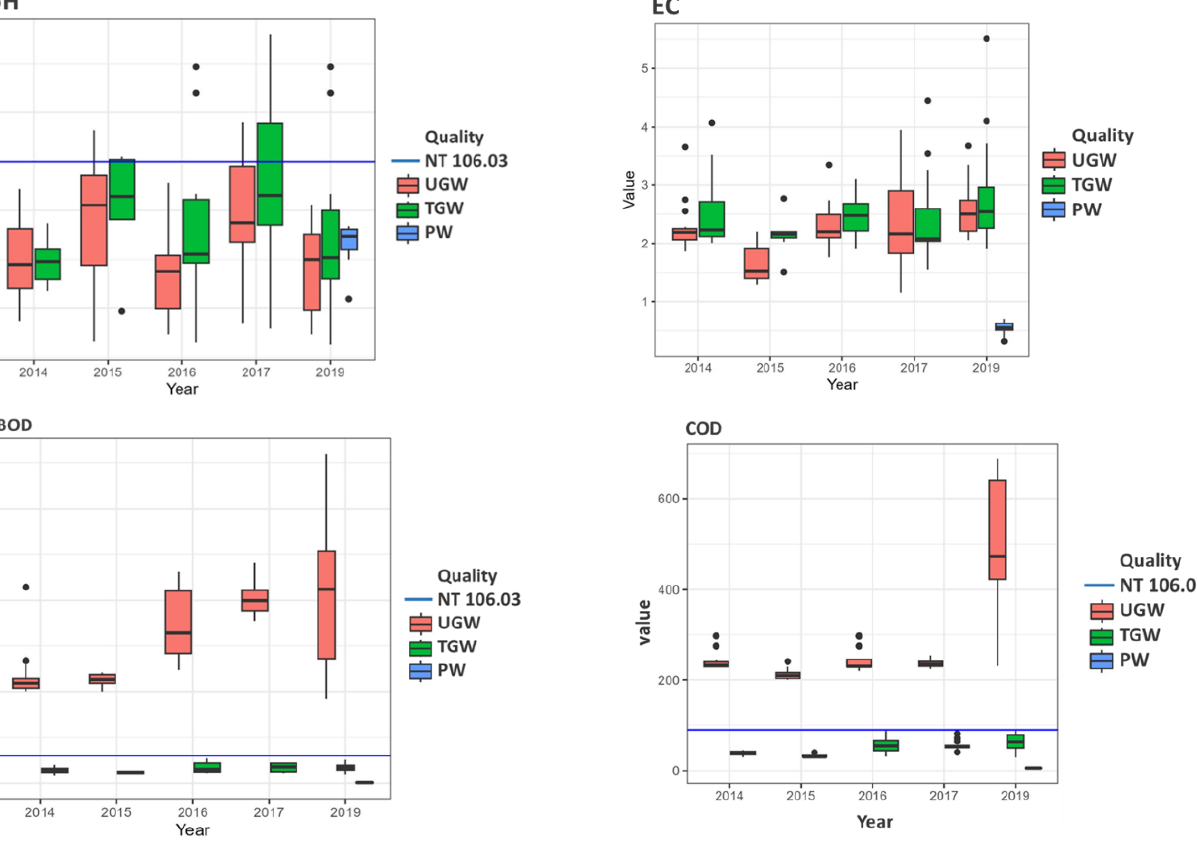
Figure 2. Boxplots of pH, ECw, BOD 5 , and COD for greywater before (UGW) and after treatment (TGW).